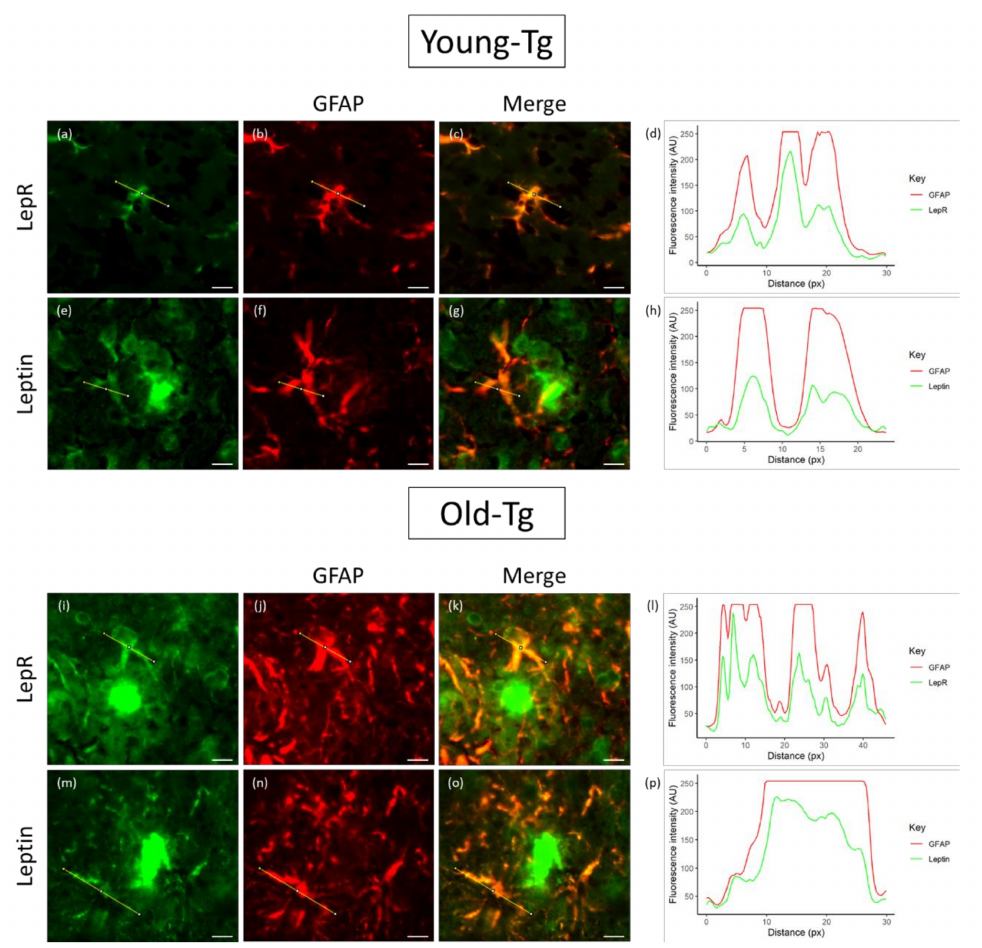
Figure 5. Colocalization of leptin and LepR with glial fibrillary acidic protein (GFAP) in astrocytes of young (10–12 week) and old (48–52 week) 5XFAD (Tg) mice. Thioflavin- S was used to stain for